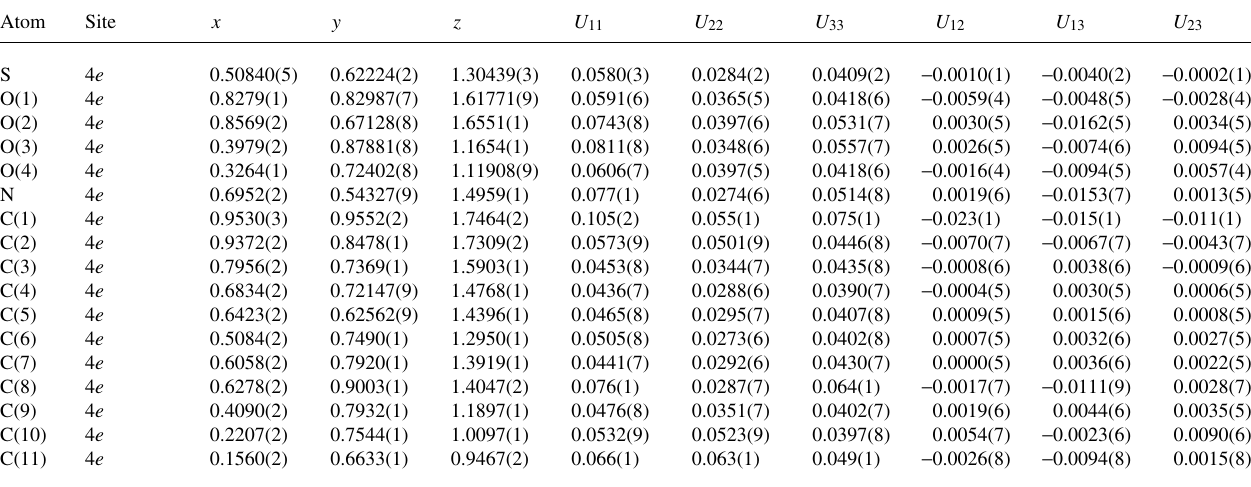
Table 3. Atomic coordinates and displacement parameters (in Å 2 )